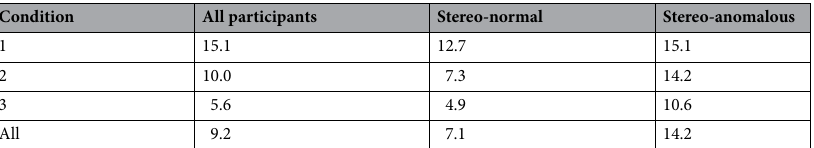
Table 5. Time to achieve learning in blocks (median value). The number of blocks needed to achieve 110% of the asymptotic threshold according to the exponential fit is calculated for each condition and for all participants, stereo-normal group and stereo-anomalous group.